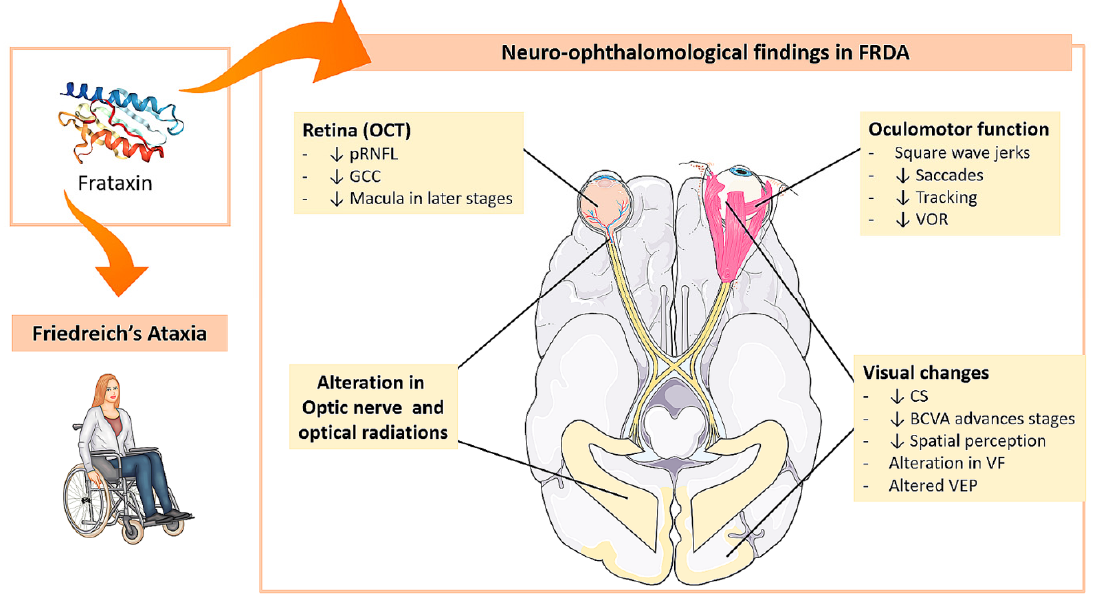
Figure 1. Neuro-ophthalmological findings in FRDA . FRDA: Friedreich’s ataxia, OCT: optical coherence tomography, pRNFL: peripapillary retinal nerve fiber layer, GCC: ganglion cell complex, VOR: vestibulo-ocular reflexes, CS: contrast sensitivity, BCVA: best-corrected visual acuity, VF: visual field, VEP: visual evoked potential. Images modified from https://smart.servier.com/ (accessed on 21 July 2021).